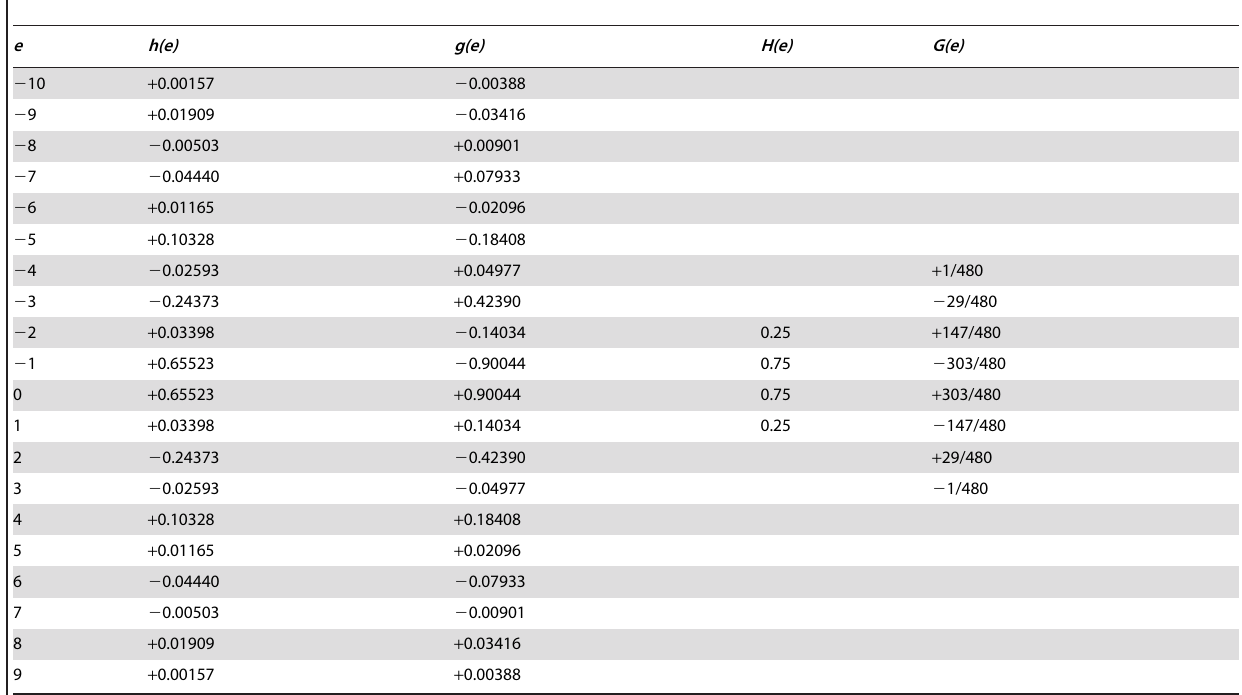
Table 1. Coefficients of the truncated decomposition filters h , g (IIR) and reconstruction filters H, G (FIR) for quadratic spline